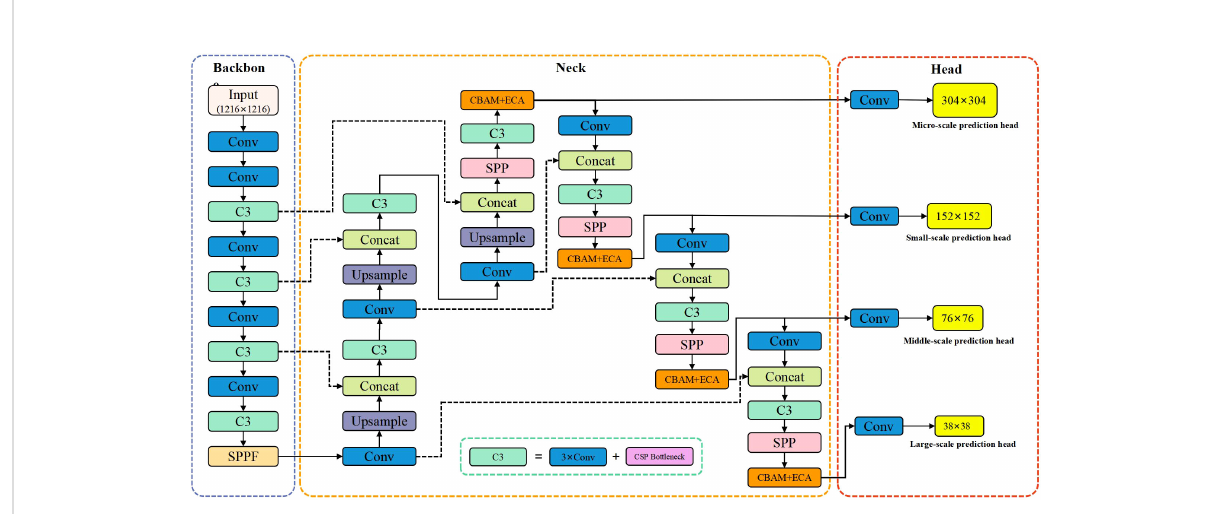
FIGURE 9 Improved YOLOv5 network structure